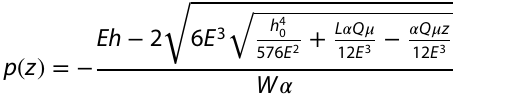
Fig. 2 Pressure drop as a function of distance from the outlet along a PDMS microchannel before ( a ) and after ( b ) 3 h soaking with mineral oil measured with pressure matching measurement ports. Coloured lines show calculated theoretical values using Eq. 1 with E = ( 2.80 ± 0.03 ) MPa in ( a ) and ( 1.32 ± 0.04 ) MPa in ( b ) where black, red, green and blue are equal to 600, 1000, 1400 and 1800